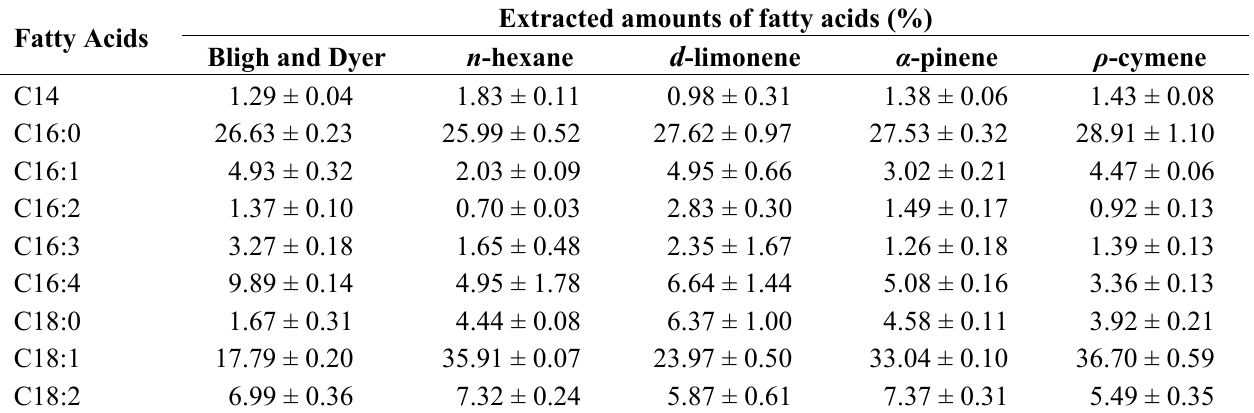
Table 2. Fatty acid composition of lipids extracted from C. vulgaris